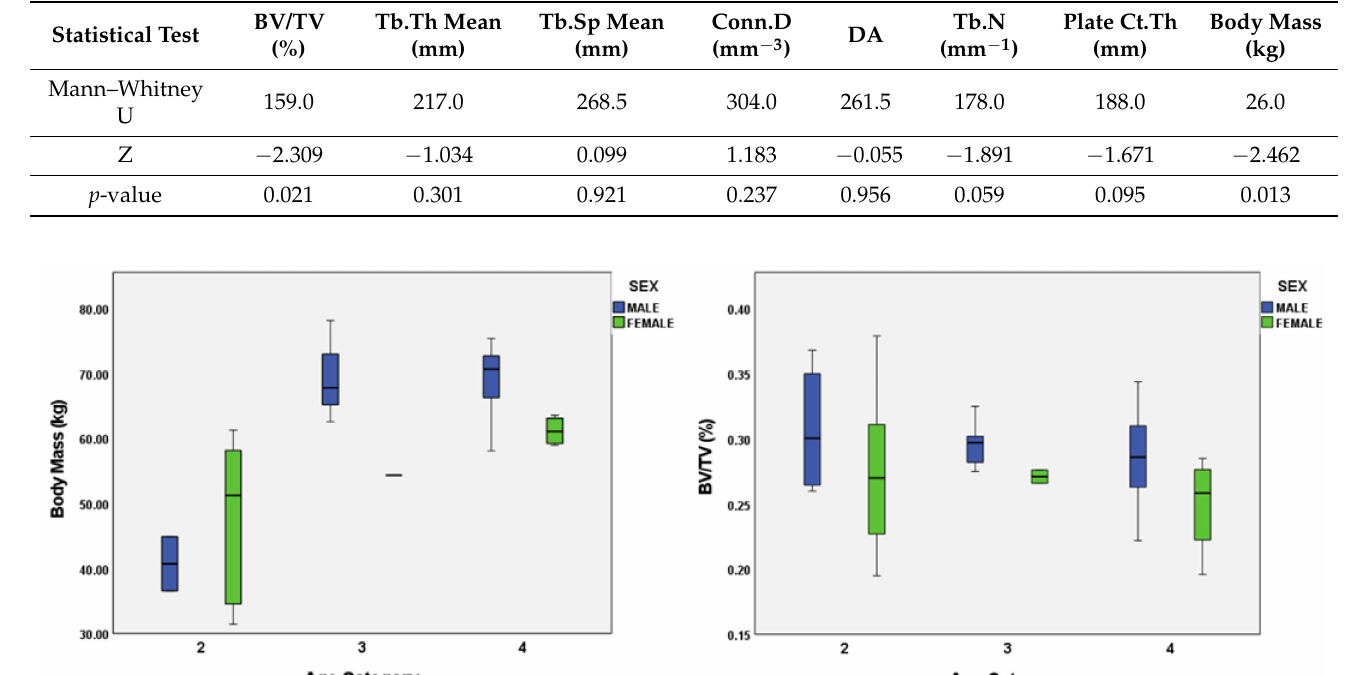
Table 8. Mann–Whitney test comparing parameters between sexes.